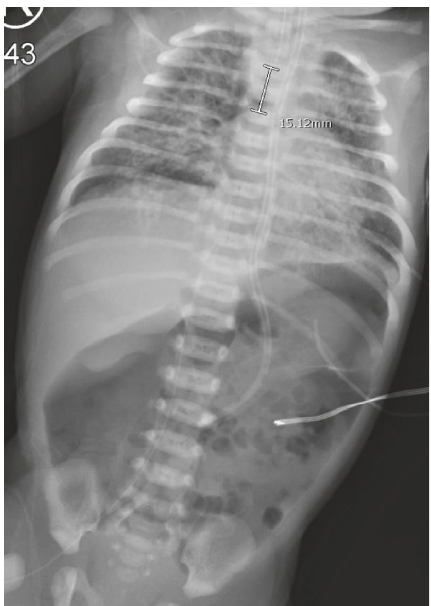
Figure 2: Babygram depicting interval development of a large pneumoperitoneum and placement of right lower extremity